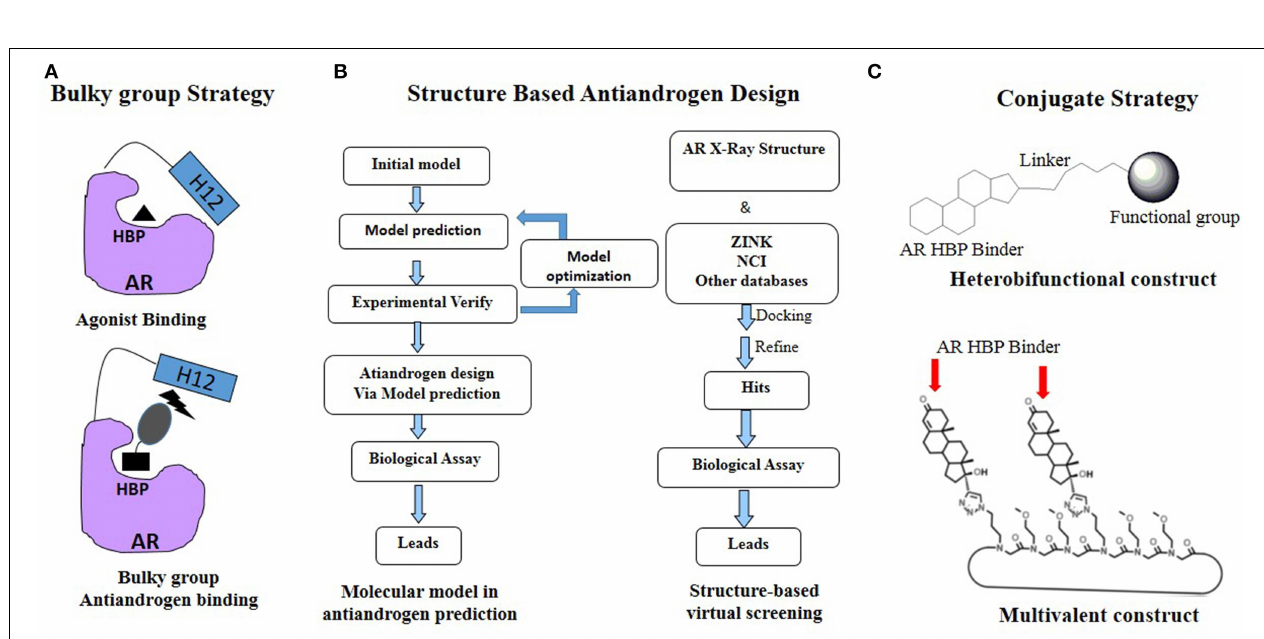
FIGURE 2 | (A) Several acquired mutations drive drug resistance: T877A mutant turns hydroxyflutamide (OHF), an active metabolite of antiandrogen flutamide in AR agonist; W741C or W741L converts bicalutamide (BIC) into AR agonist; a novel mutant F876L was identified inducing the resistance to enzalutamide and ARN509. (B) The crystal structure (PDB-ID: 2ax6) of T877A LBD/ hydroxyflutamide (OHF) shows adopting a agonistic conformation; (C) the crystal